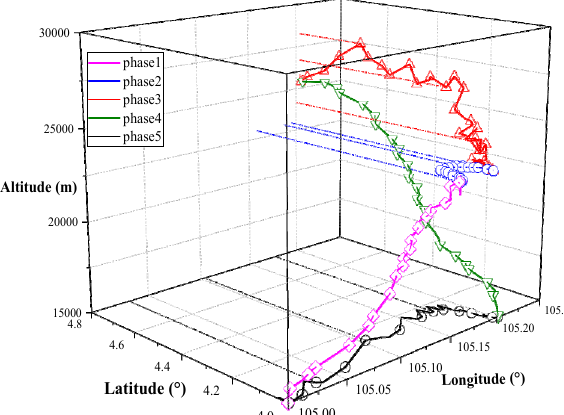
Figure 6. Optimal three dimensional flight trajectory with minimal battery mass based on gravity energy reserving and mission altitude.